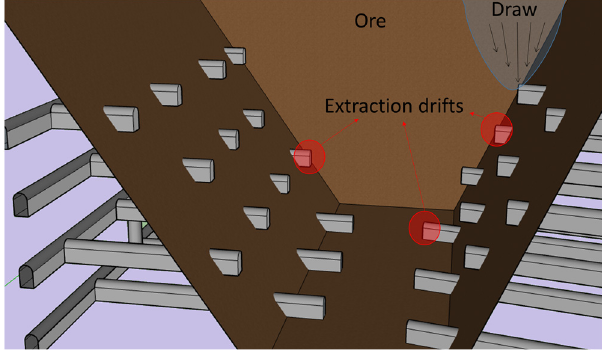
Figure 1. Example of inclined caving design, isometric view.